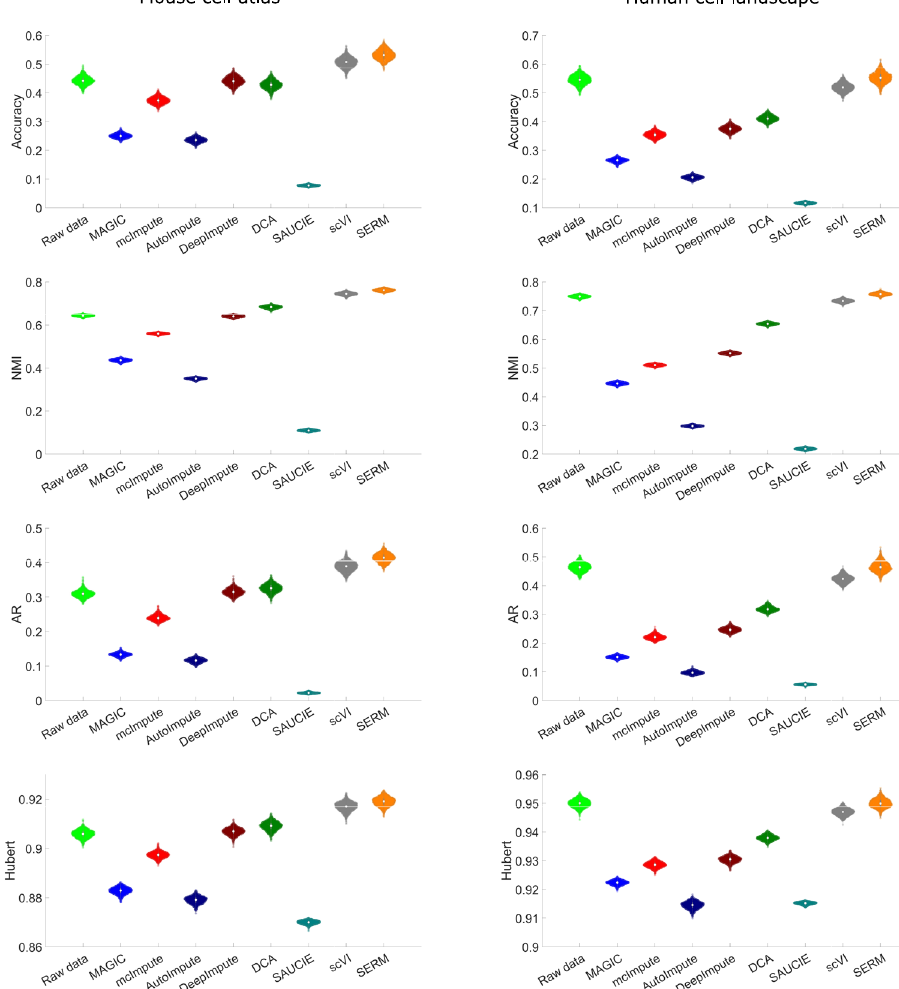
Fig. 9 | Accuracy and three cluster quality indices (NMI, AR, and Hubert) computedfromt-SNEresultsofthe rawand imputeddata by different methods for the MCA and HCL data. Source data are provided as a Source Data fi